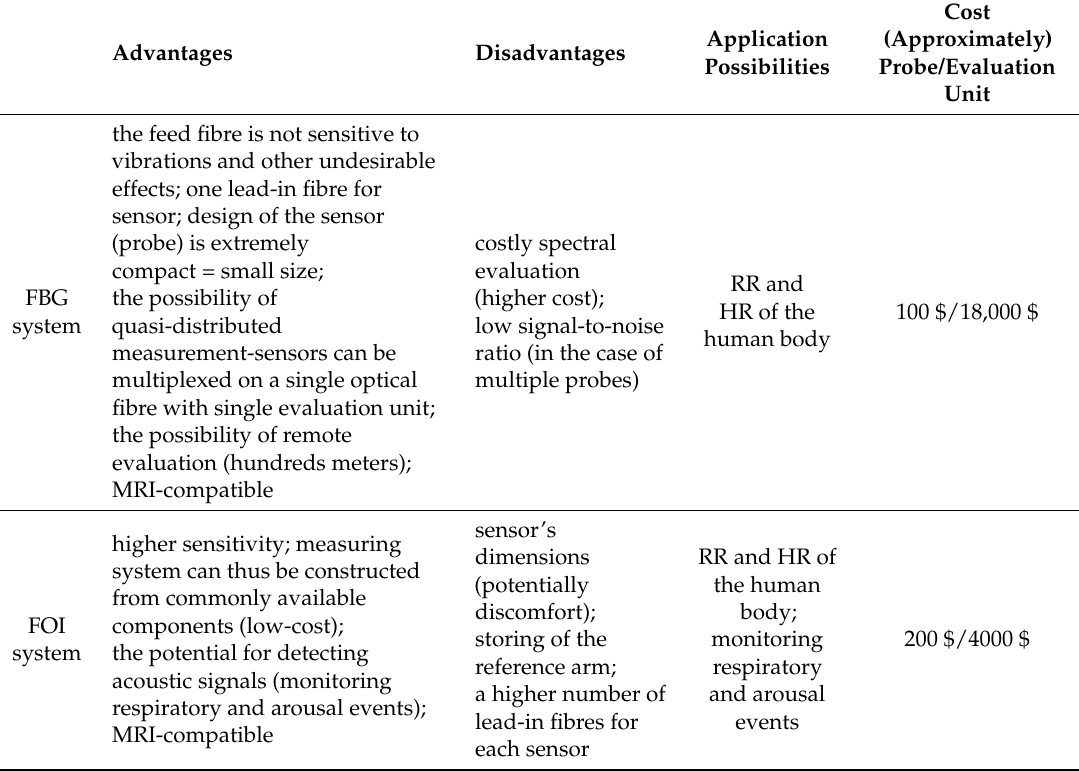
Table 1. A comparison of both fibre-optic